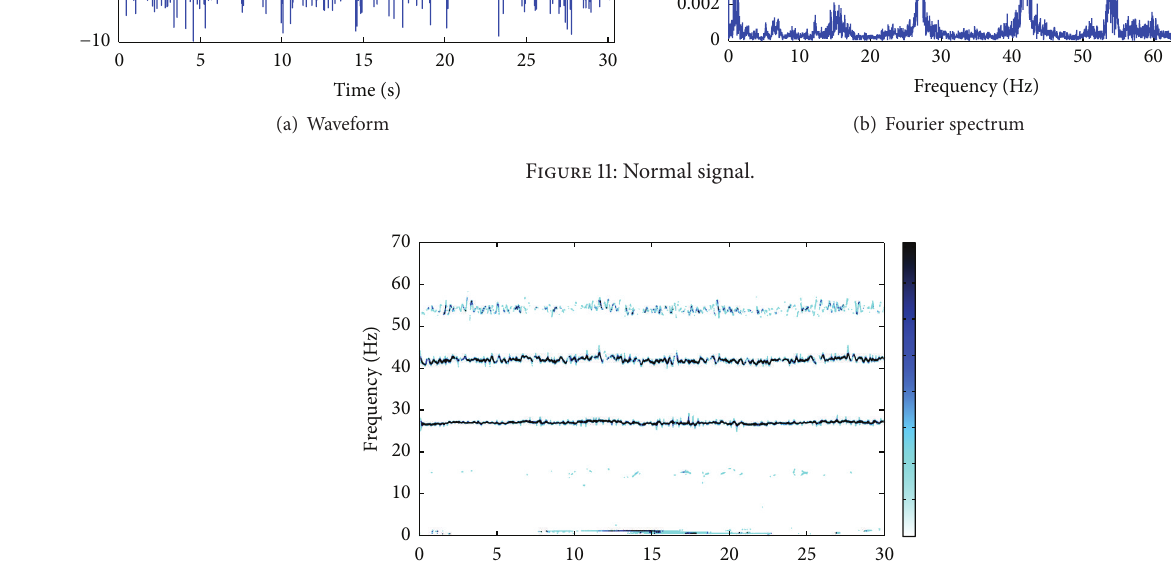
Figure 11: Normal signal.